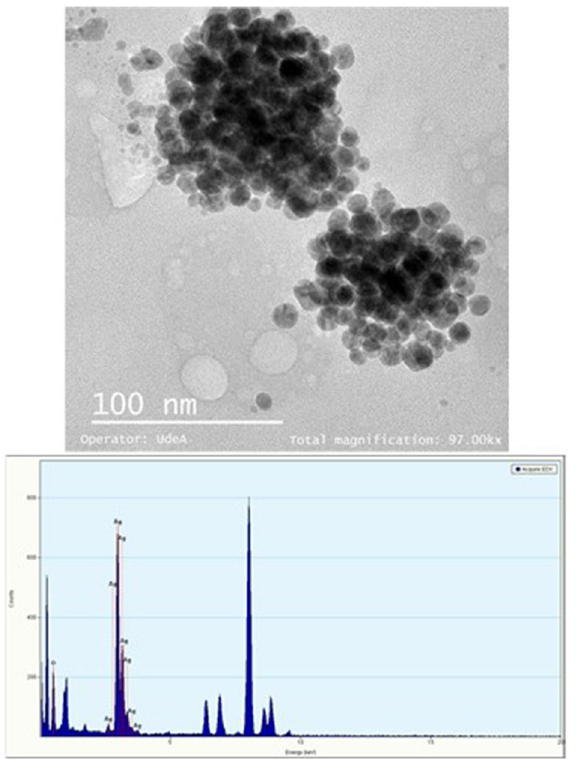
Figure 9. Transmission Electron Microscopy (TEM) images and EDX spectra of silver nanoparticles synthesized in the CS samples of the fungus anamorphous Bjerkandera sp. R1. Growth time of fungus: 8 days. Incubation time: 144